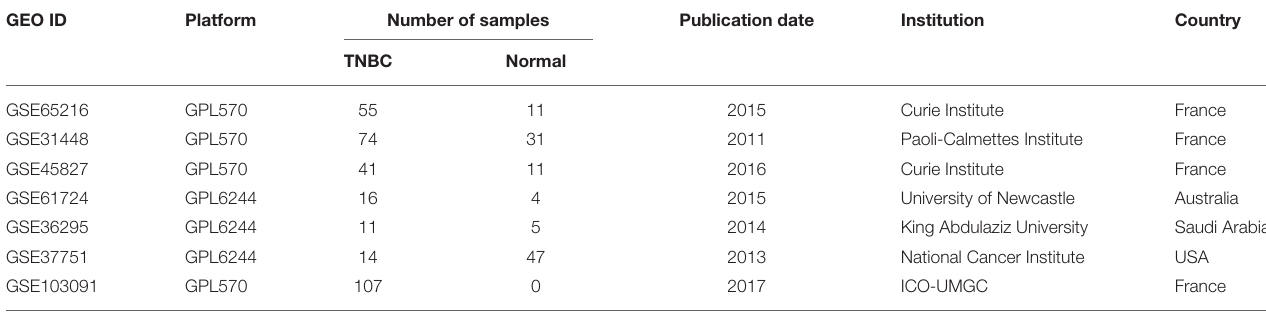
TABLE 1 | Characteristics of the included